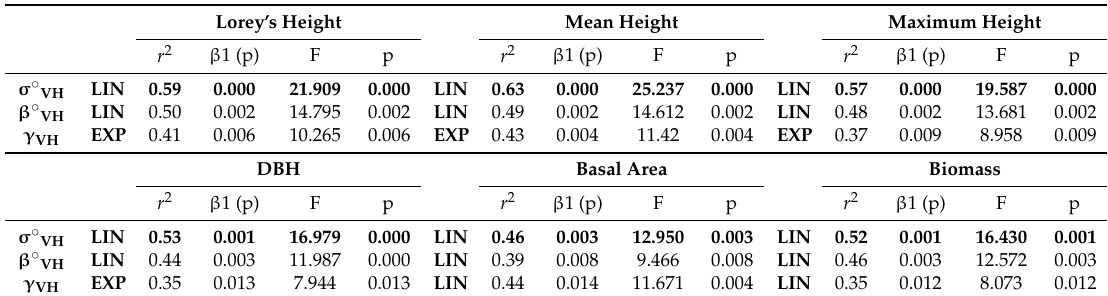
Table 6. Models that showed higher r 2 values in the three radar attributes with VH polarization as an explanatory variable ( p >